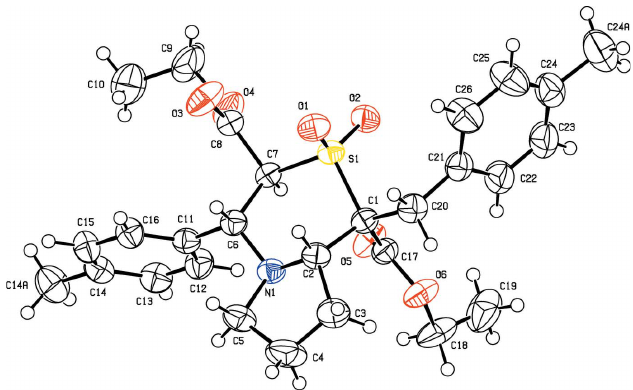
Figure 2 Displacement ellipsoid plot (50% probability level) of title compound (II), showing the atom-labelling scheme.